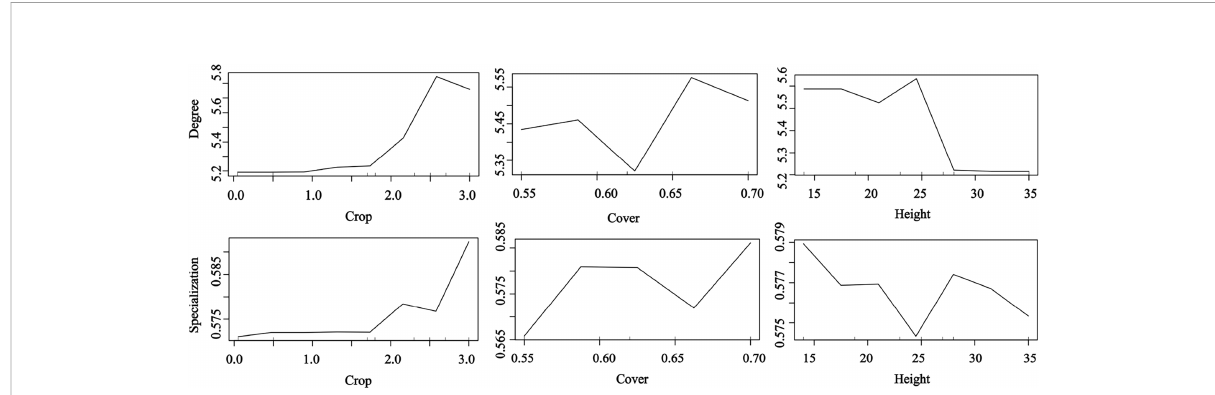
FIGURE 5 Effects of plant traits on the network metrics at the species level (degree and specialization) representing a fragmented forest in Southeast China. Results were determined using the Random Forest algorithm and showed the partial effects of independent variables on degree and specialization,